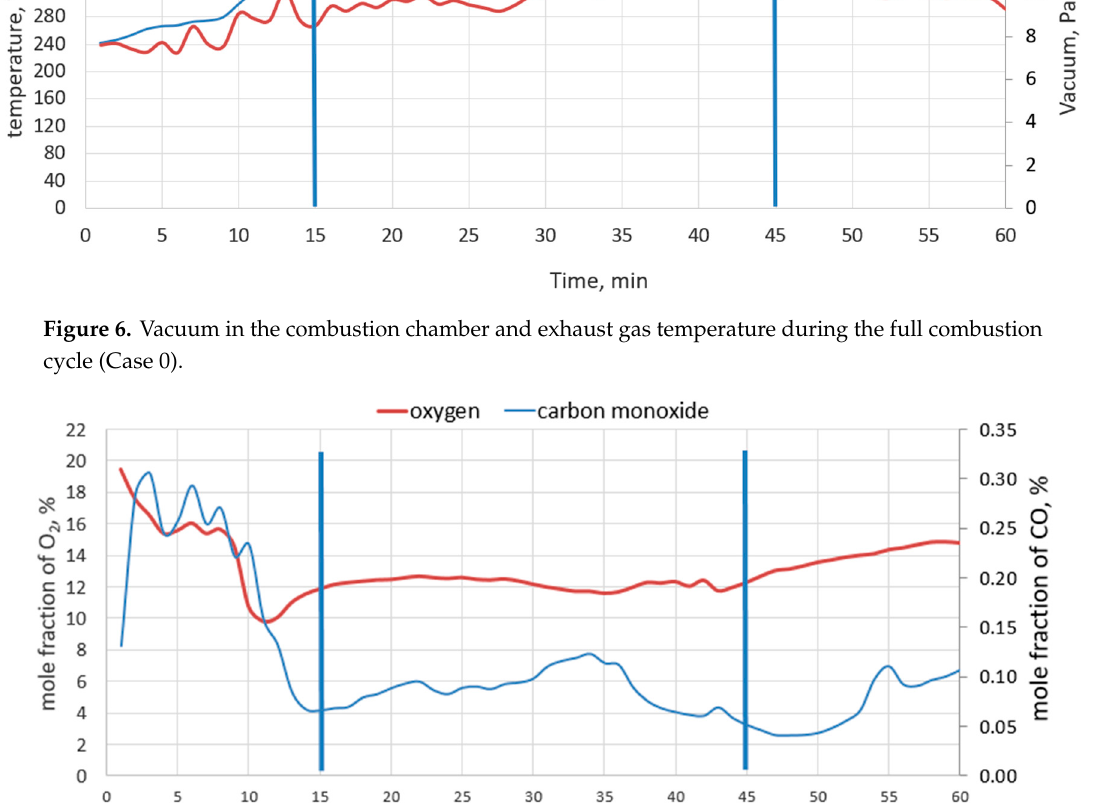
Figure 7. The concentration of O 2 and CO in the exhaust gas during the full combustion cycle (Case 0).